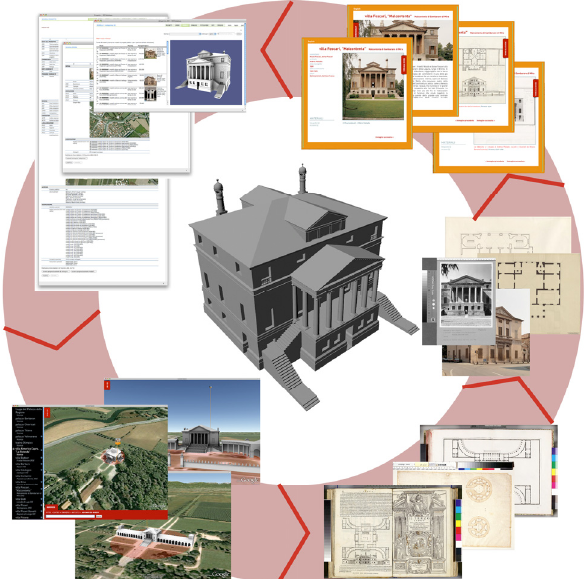
Figure 1. Data relationship structure and 3D model as browsable